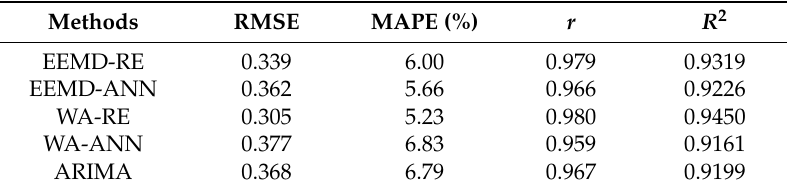
Table 4. Predictive accuracy of different models with monthly